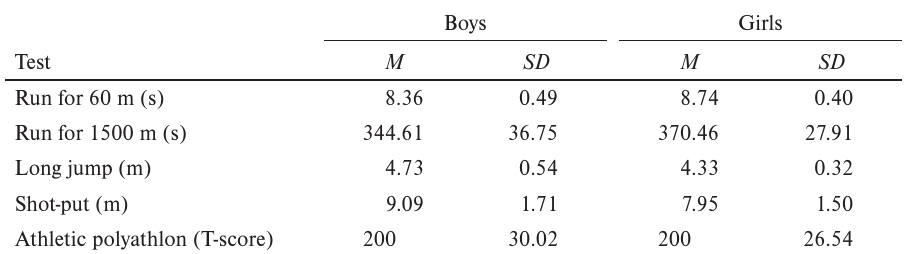
The results of the athletic polyathlon (final tests) of boys and girls – grade 9